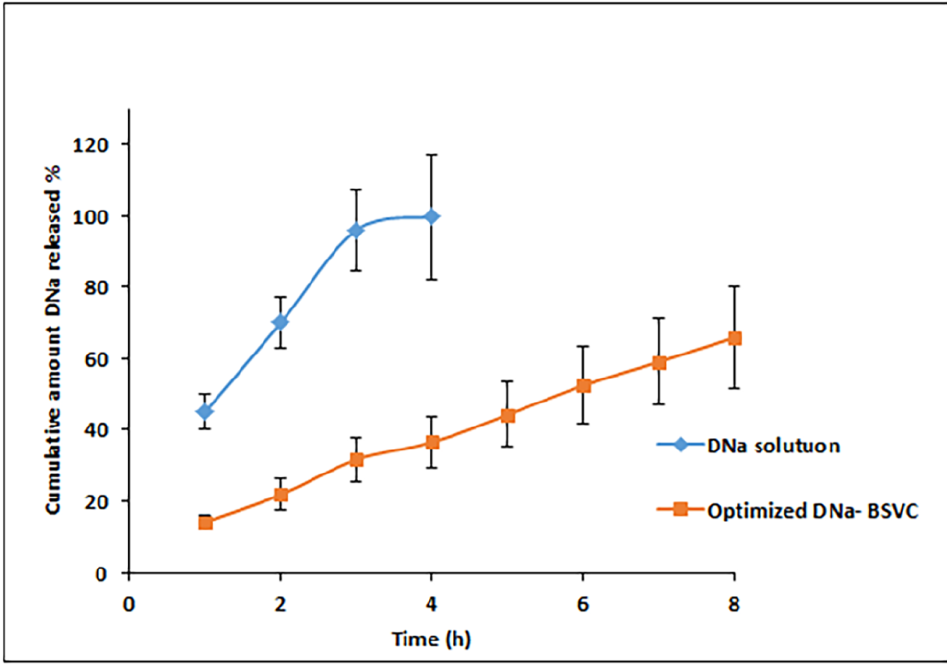
Figure 4. In vitro release profile of DNa from BSVC (optimal formulation) and drug solution.